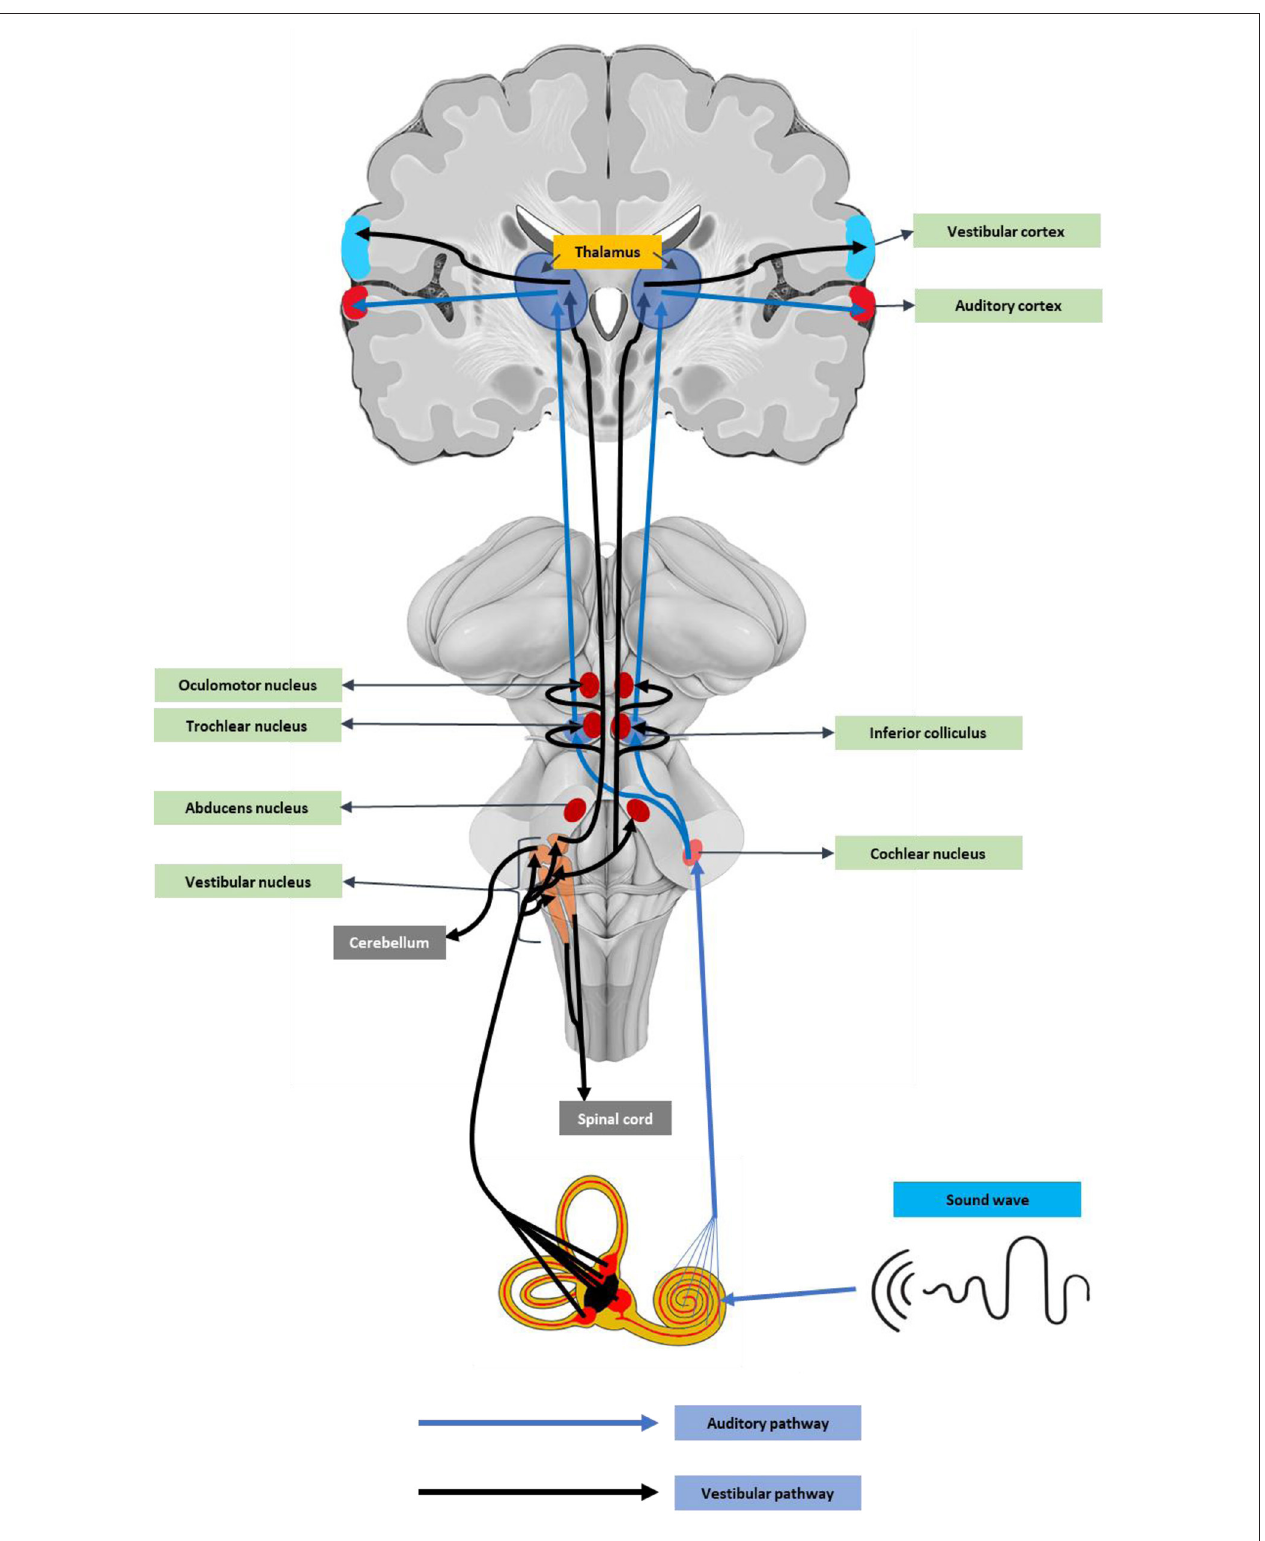
FIGURE 1 | Vestibulocochlear